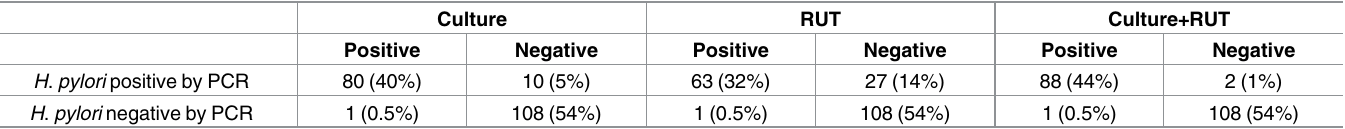
Table 4. Concordance between diagnostic tests.